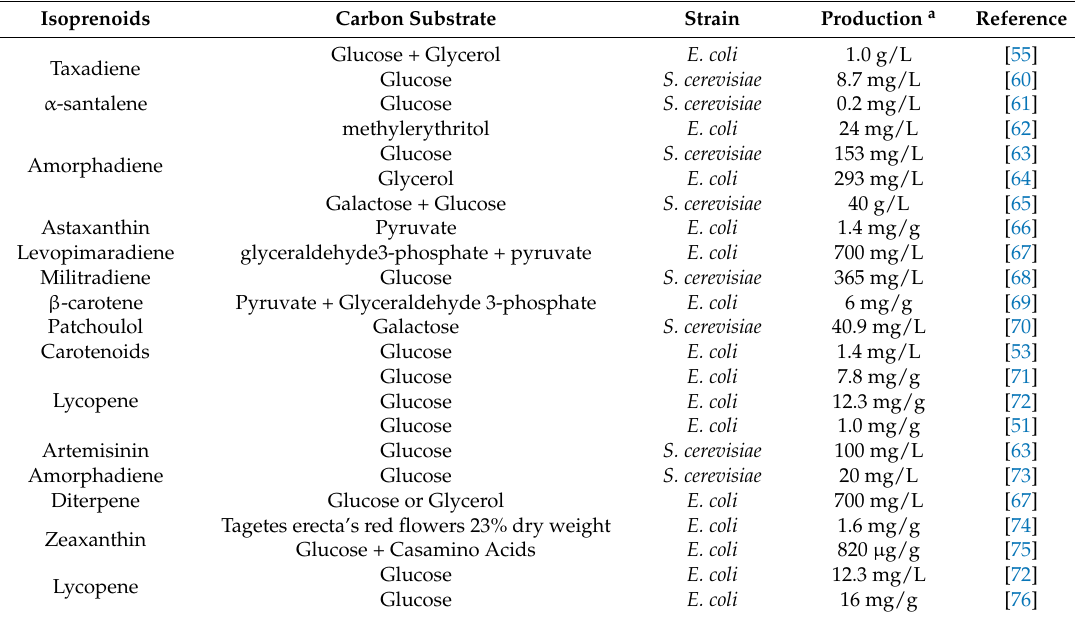
Table 2. Microbial production of representative isoprenoids from variable carbon